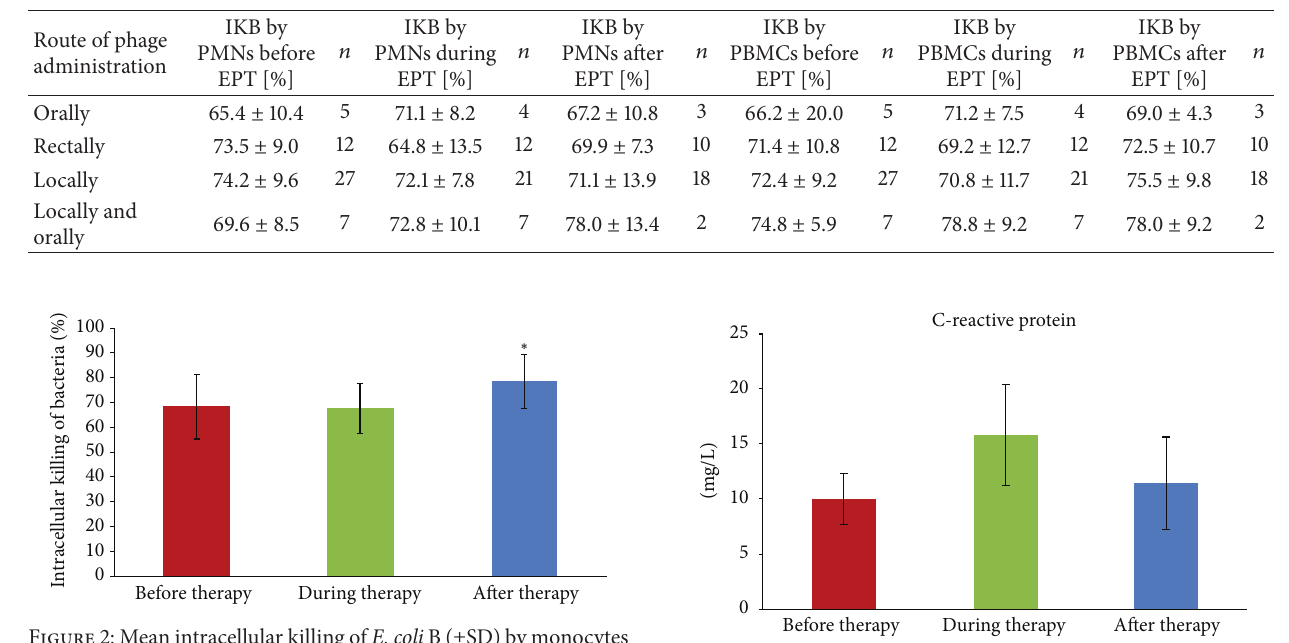
Figure 2: Mean intracellular killing of E. coli B ( ± SD) by monocytes (in the mononuclear cell suspension) isolated from patients with urinary tract infections before ( 𝑛 = 18 ), during ( 𝑛 = 17 ), and after phage therapy ( 𝑛 = 13 ). ∗ Statistically significant increase of IKB observed after EPT compared to the value at the beginning of EPT (Mann-Whitney 𝑈 test).